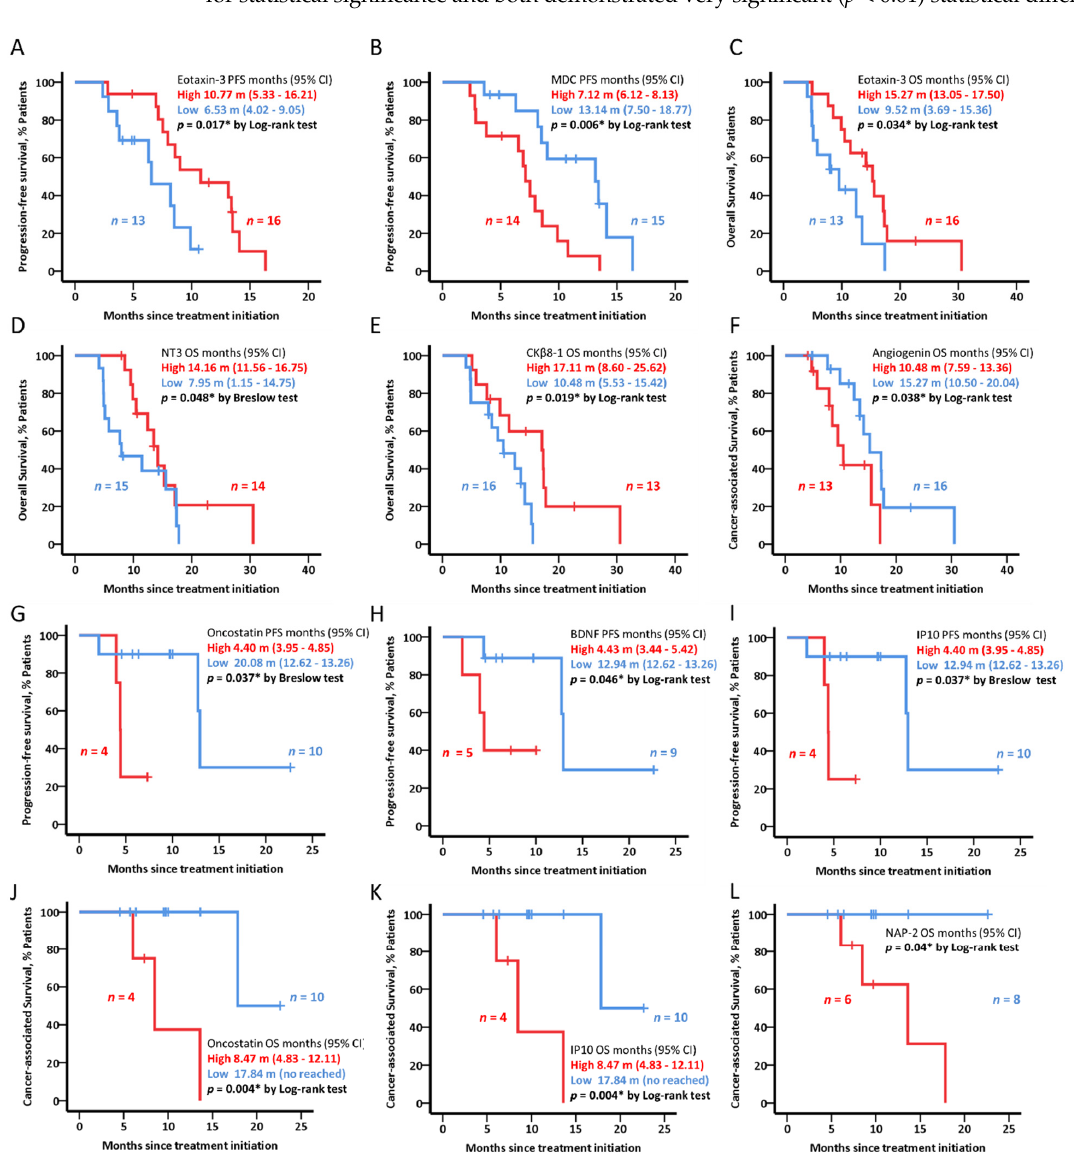
Figure 3. PFS/OS curves for baseline cytokine levels, BL patients ( n = 29). Kaplan–Meier plots rep-